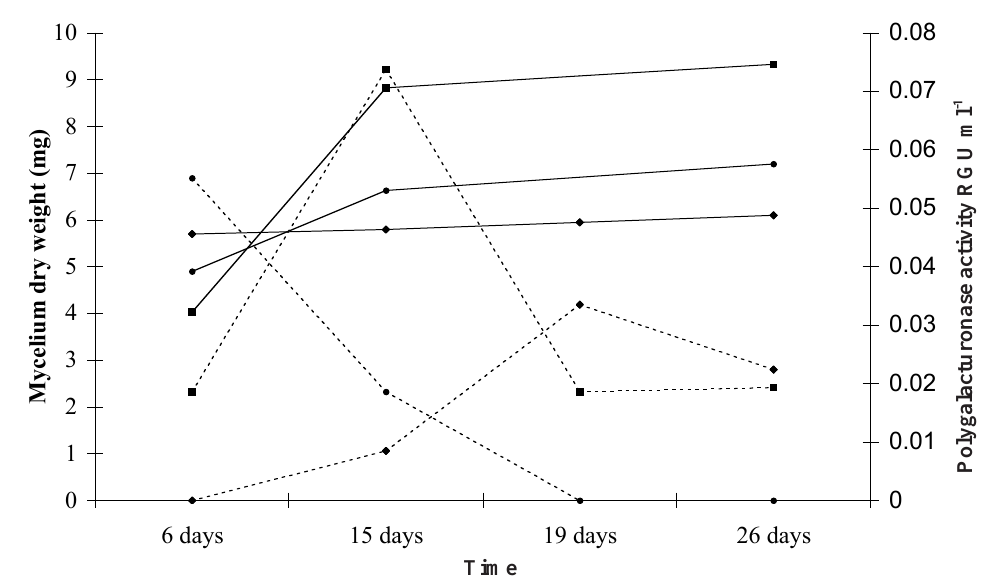
Fig. 5. Growth (––) and polygalacturonase production (- -) by three isolates of Phaeomoniella chlamydospora ( Pch 52, (cid:1) ; Pch 16, (cid:4) ; Pch 24, (cid:2) ). Polygalacturonase activity is expressed as RGU ml -1 .